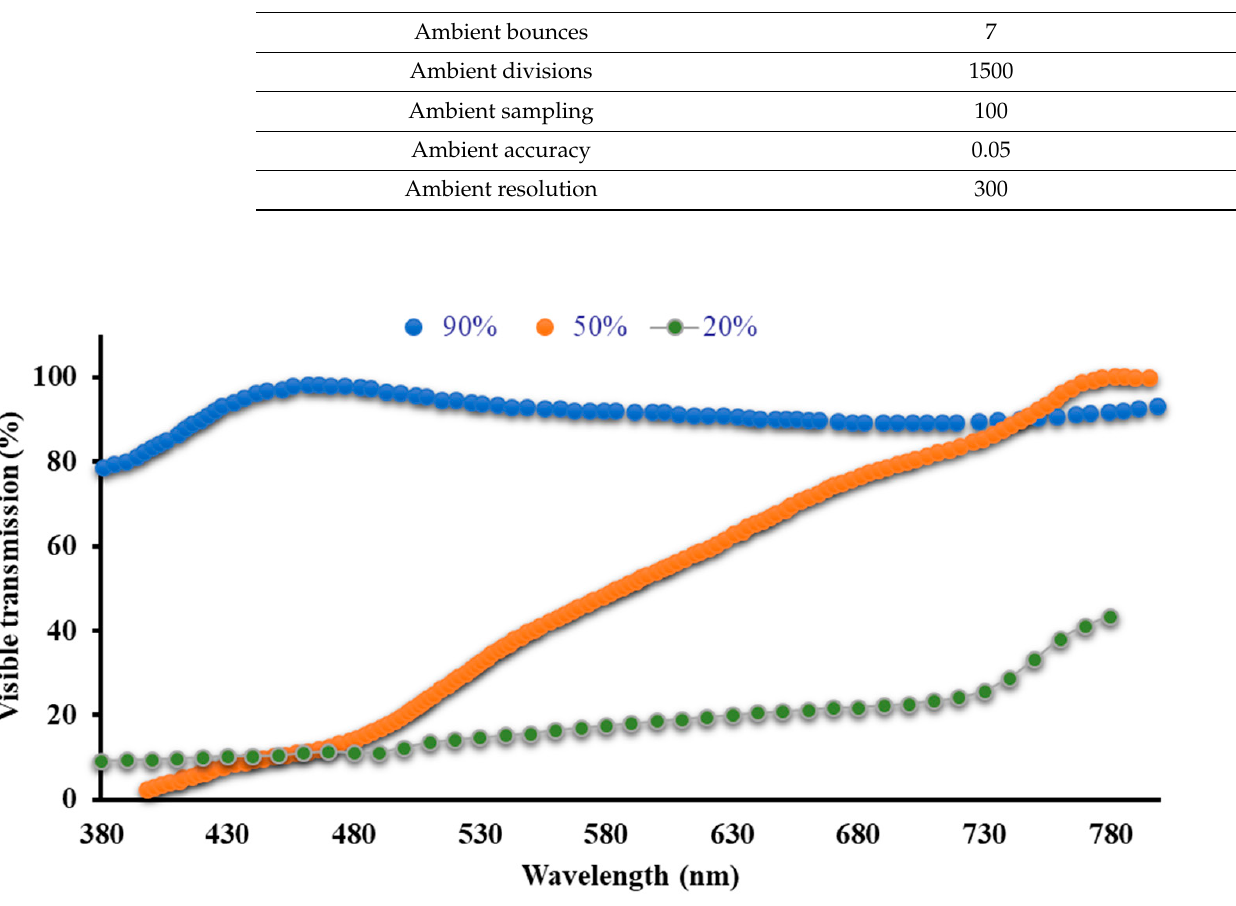
Figure 4. Wavelength dependent visible transmission for 20% CdTe [50], DSSC 20% [51]. Graphs are reproduced from [50,51]. Reprint with permission [50,51],2021, Elsevier. Average visible light transmittance values τ v are given by [52]: τ (cid:2906) (cid:3404) ∑